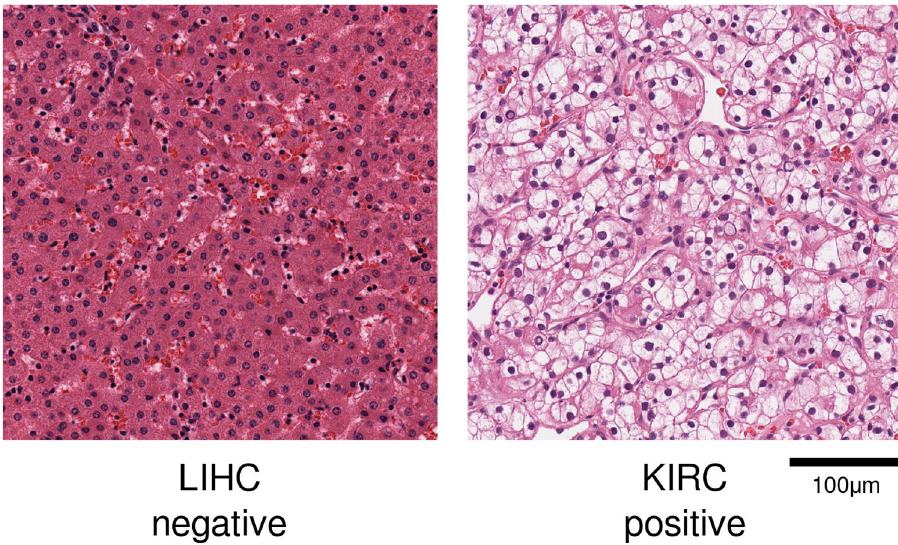
Figure 5. Representative images of the morphological features unique to LIHC negative and KIRC positive slides are shown. LIHC (negative) shows cords of reddish polygonal hepatocytes, and KIRC (positive) shows clear cell clusters with distinct cellular